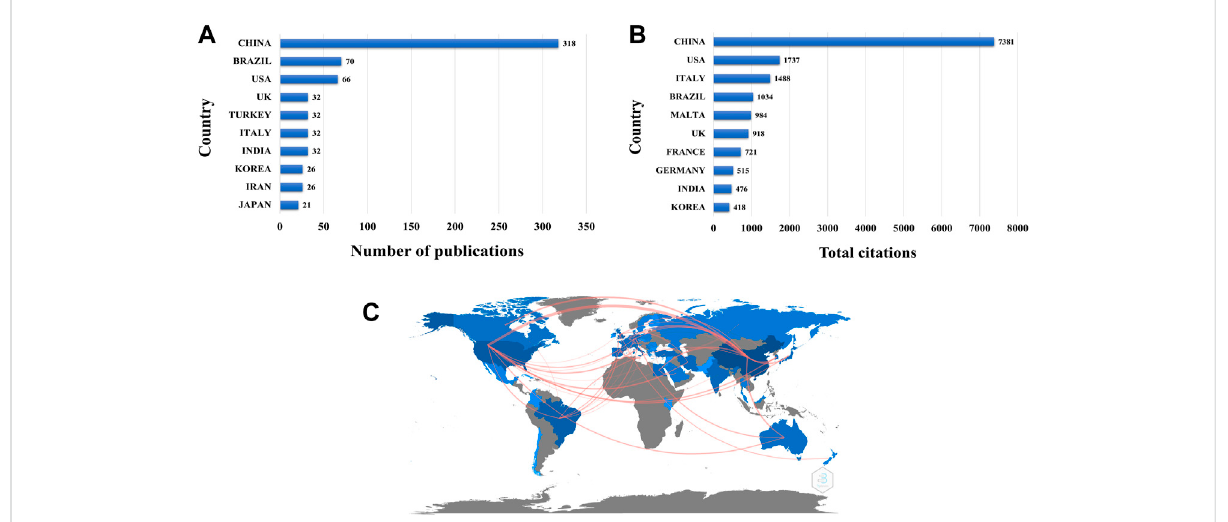
FIGURE 3 CountriescontributingtoCSBinmedicine fi eld. (A) ArticlesofCSBinmedicine fi eldbycountry/region. (B) Totalcitationcountry/regionranking ofCSBinmedicine fi eld. (C) Worldmapshowingresearchcollaborationsamongcountries/regionassociatedwithCSBinmedicine.Dakerbluecolor indicates a higher collaboration rate. Countries with more than fi ve shared papers are shown by